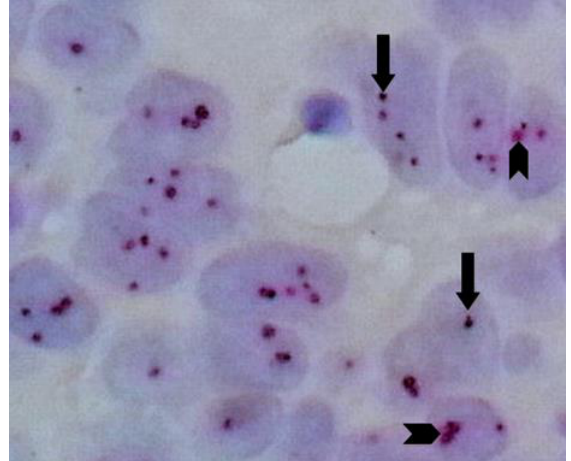
Fig. 8. Invasive Ductal Carcinoma With Amplified HER2 Gene by Silver DNA in Situ Hybridization; HER2 gene black SISH intranuclear signals (arrows) typically appear smaller than chromosome 17 red ISH intranuclear signals (arrow heads) with an overall ratio of (black SISH signals/red ISH signals) > 2. (60X). Table. 3. Association Between Age and HER2 Gene Status Age groups HER2 gene status